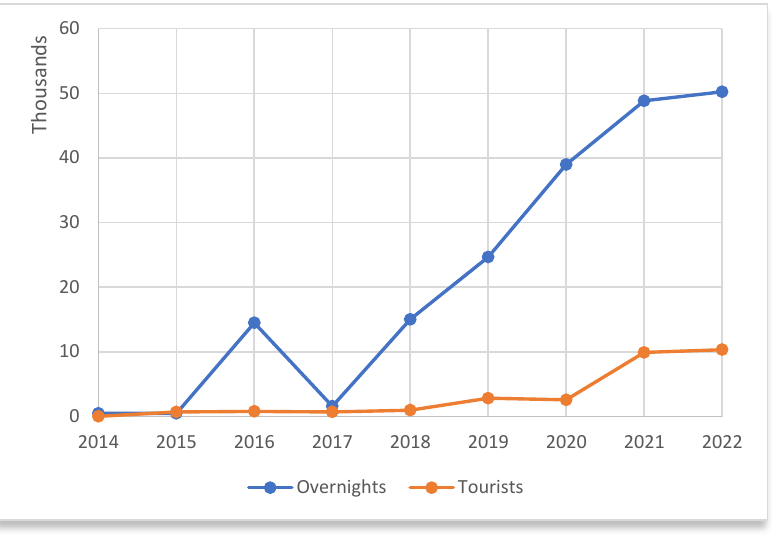
Figure 7. Trend of overnight stays and number of foreign tourists 2014 – 2022.